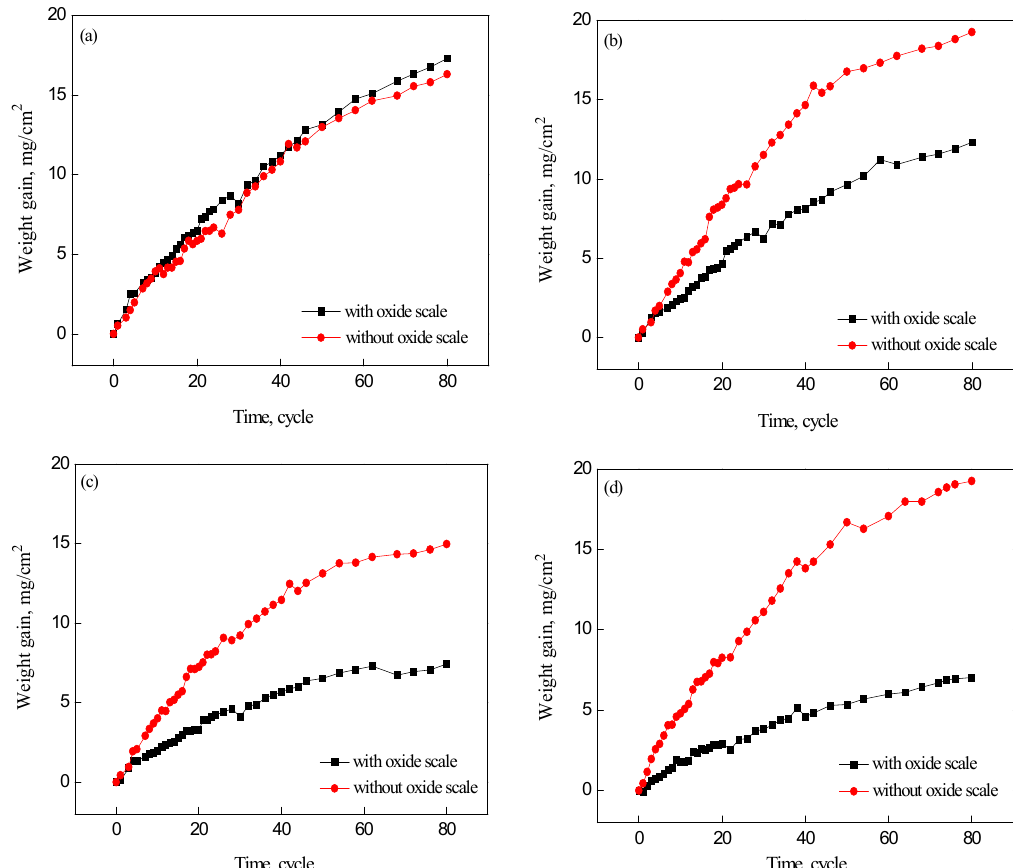
Figure 2. Relationship between weight gain and corrosion time for the samples with and without the oxide scale: ( a ) type I; ( b ) type II; ( c ) type III; ( d ) type IV.